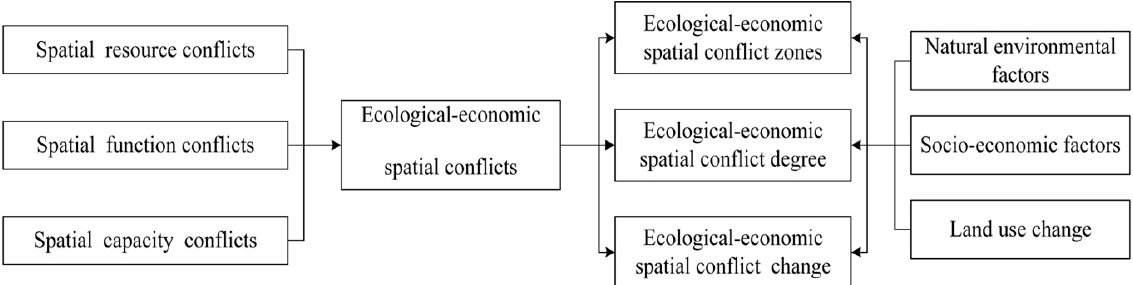
Figure 2. Research framework diagram.